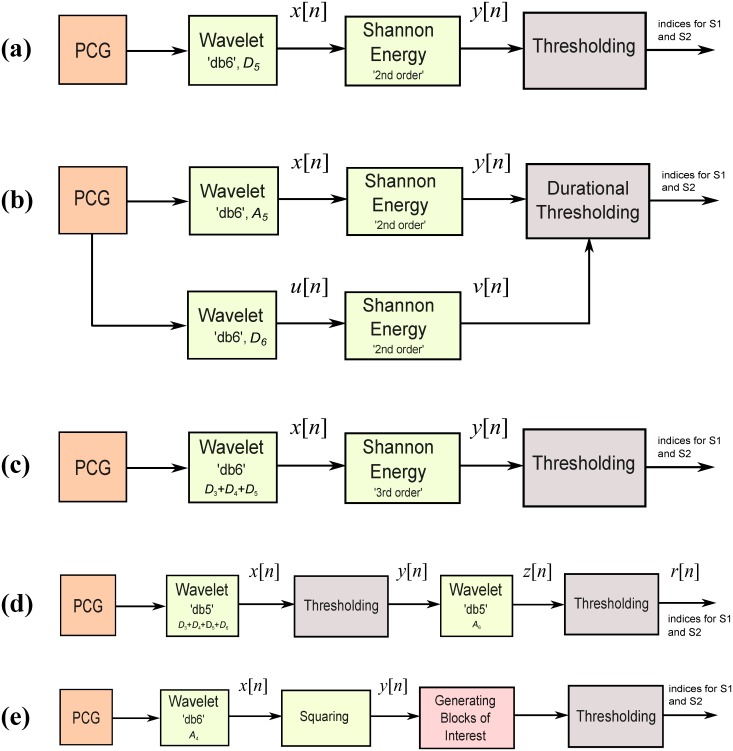
Flowcharts for five methods to detect S1 and S2 waves in heart sounds.(a) Method I, (b) Method II, (c) Method III, (d) Method IV, (e) Method V.